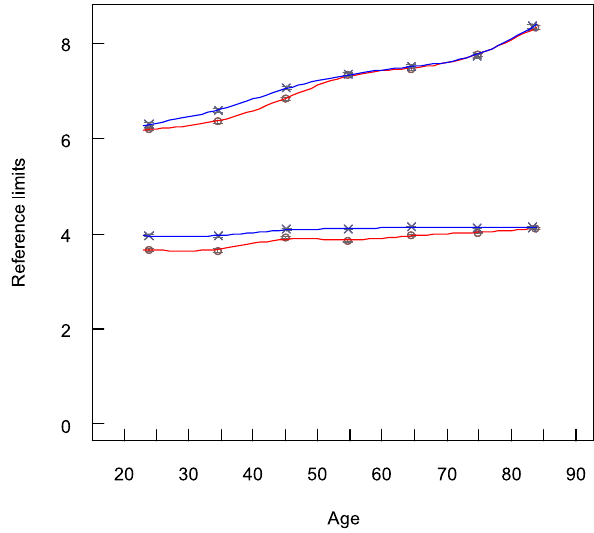
Figure1: Referencelimitsofplasmaglucose(mmol/L)dependingon age (years) separated by sex. Lower lines represent the 2.5th percentile, upper lines the 97.5th percentile, blue lines represent men (n=86132), red lines women